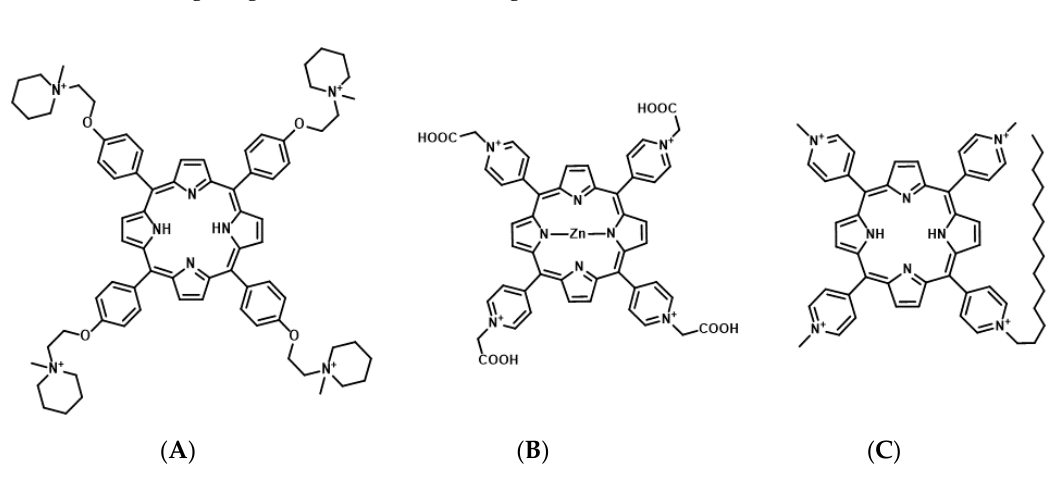
Figure 5. Chemical structures of 5,10,15,20-tetra-{4-[2-(1-methyl-1-piperidinyl)ethoxy]phenyl} porphyrin (TMPipEOPP) ( A ), Zn(II)-5,10,15,20-tetrakis(N-carboxymethyl-4-pyridinium)porphyrin